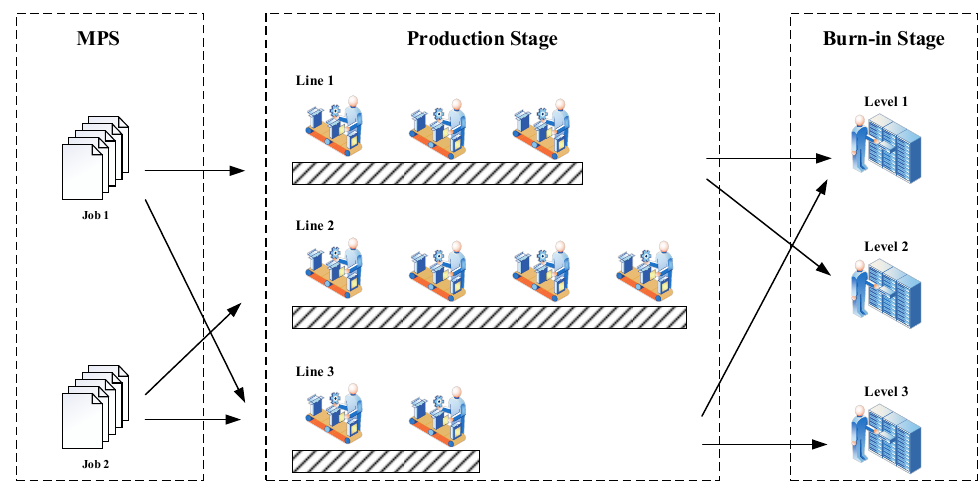
Figure 1. Illustration of the production process considered in this